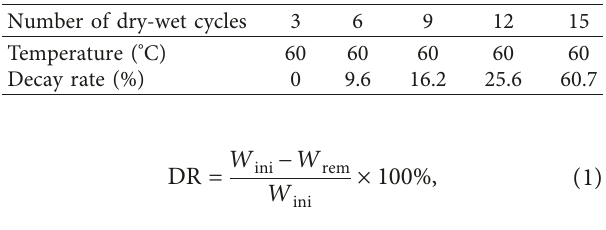
Table 2: Effect of the number of dry-wet cycles on rock decay rates